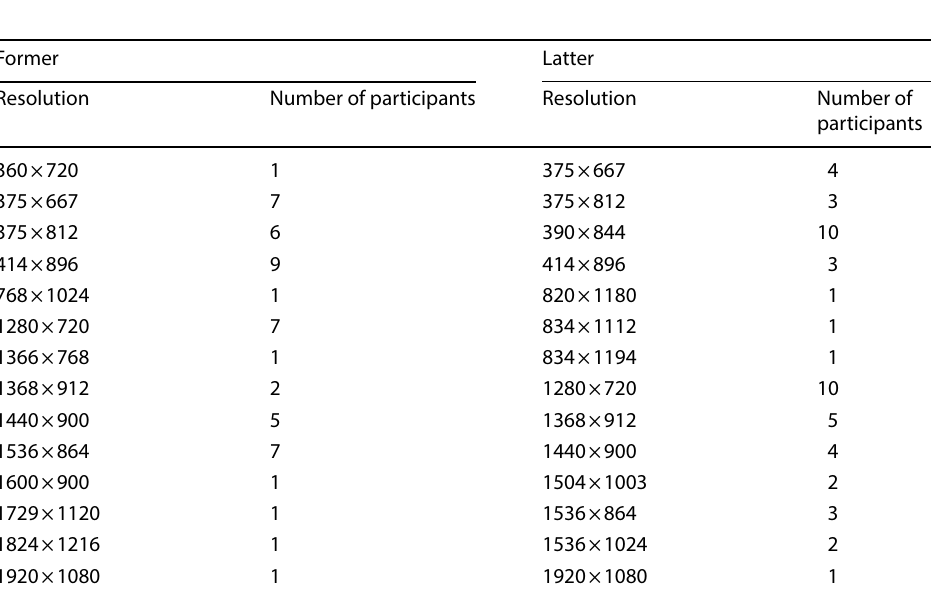
Table 1 Type and number of screen resolutions of devices used by